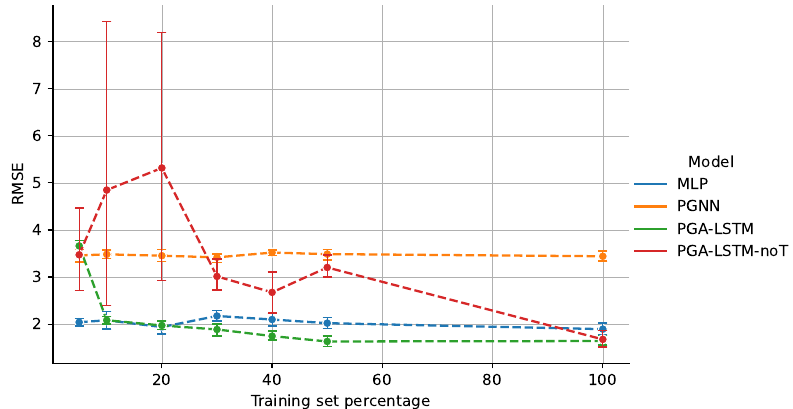
Figure 2. Lake temperature, RMSE of the models varying the training set size.